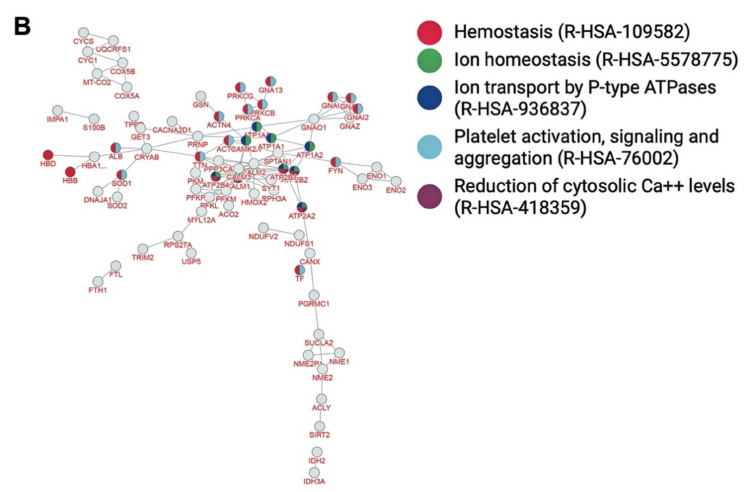
Figure 3. Enriched PPI network of myelin ( A ) and sub-PPI network of metalloproteome ( B ) based on most significant pathways in which myelin proteins are involved.